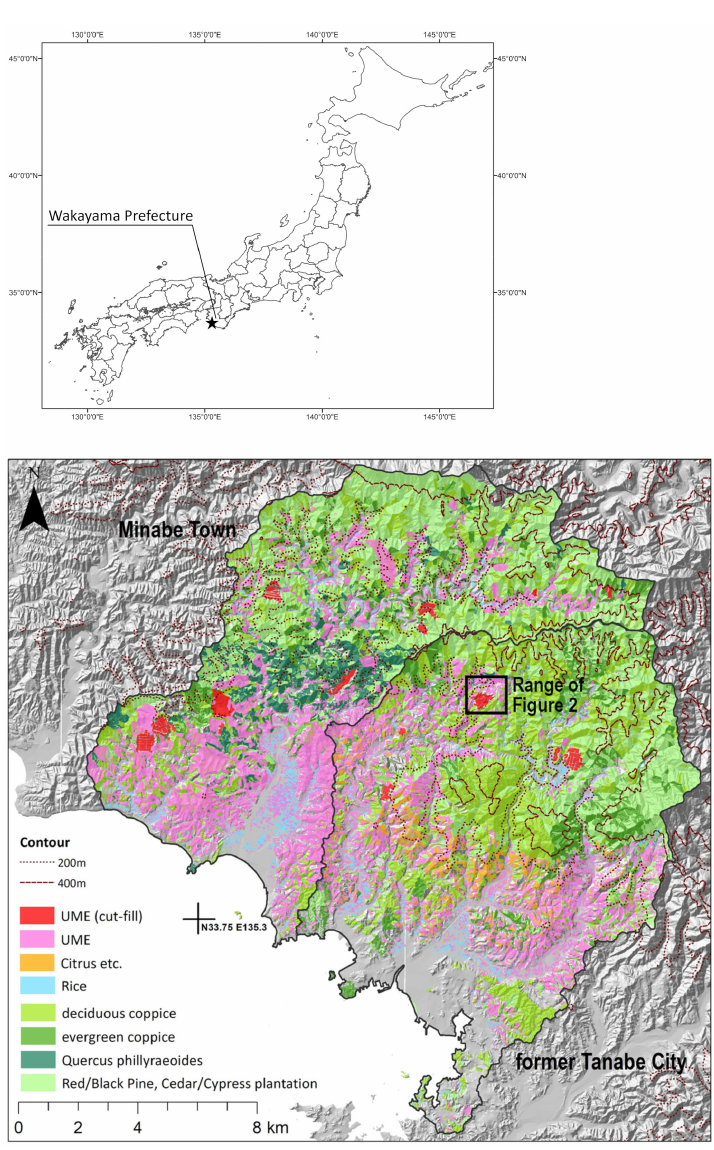
Figure 1. Study area (land-use data is adapted from